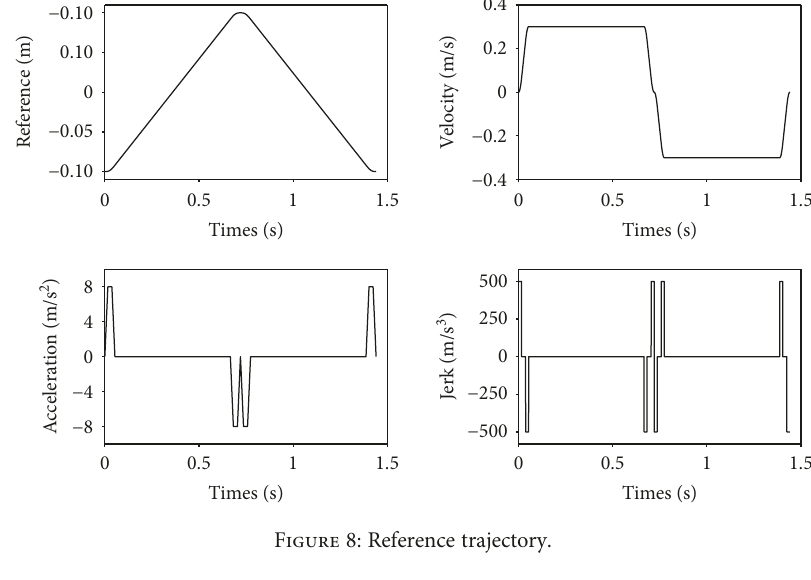
Figure 8: Reference trajectory.